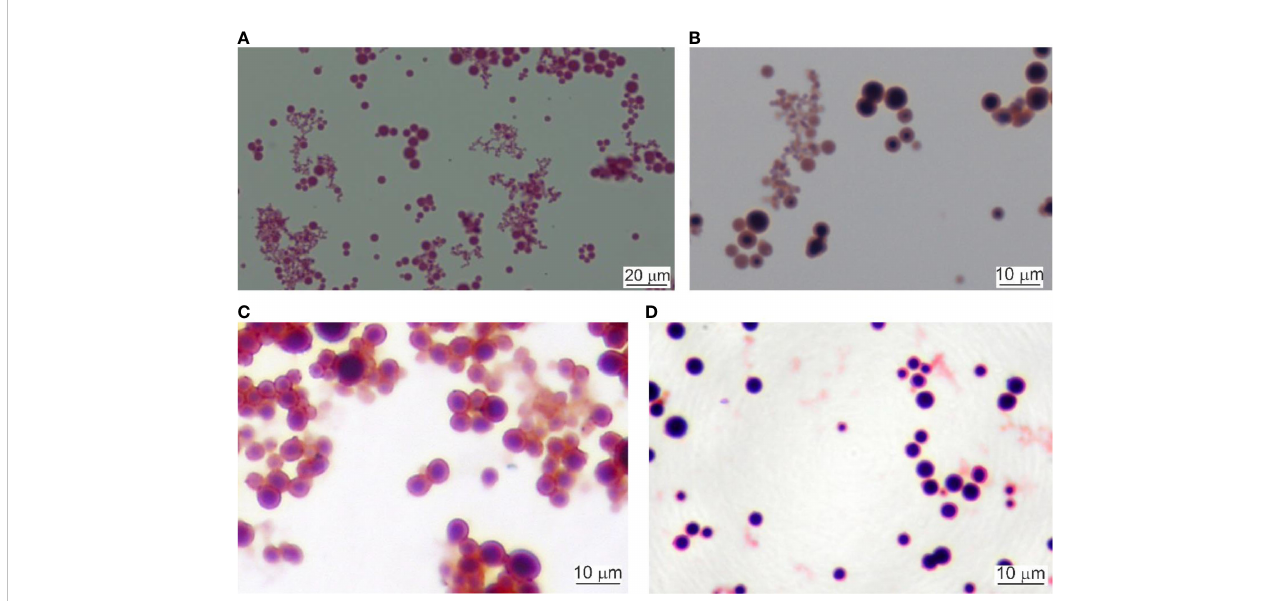
FIGURE 2 Light microscopy of cultured blood microbiota. (A) Gram staining at 4 hours of culturing, 800×. Scale bar 20 µm. (B) Gram staining at 6 hours, 1000×. (C, D) Cultures stained at 24 hours of culturing, 1000×. Scale bar 10